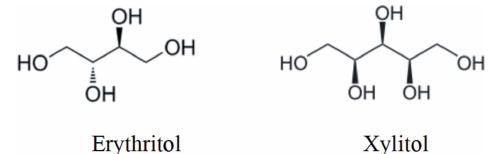
Figure 1 Structures of erythritol and xylitol.